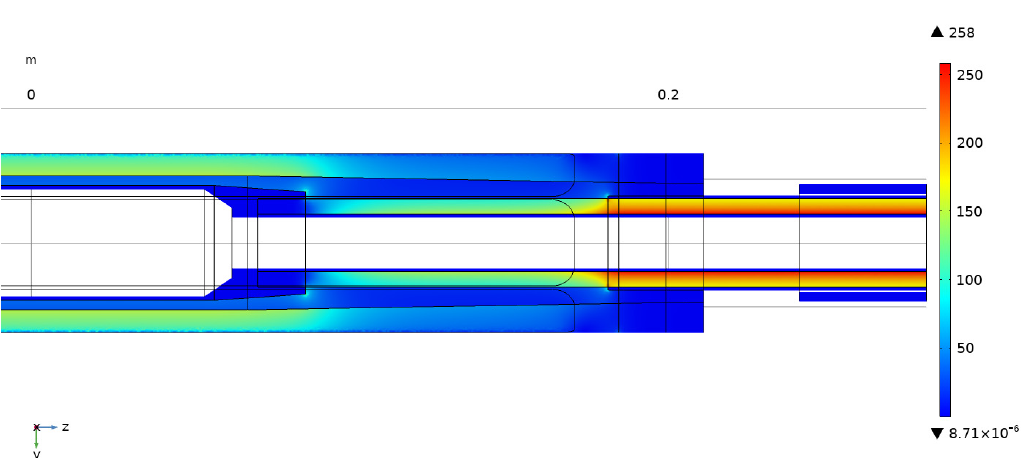
Figure 5. Electric field simulation of the joint.